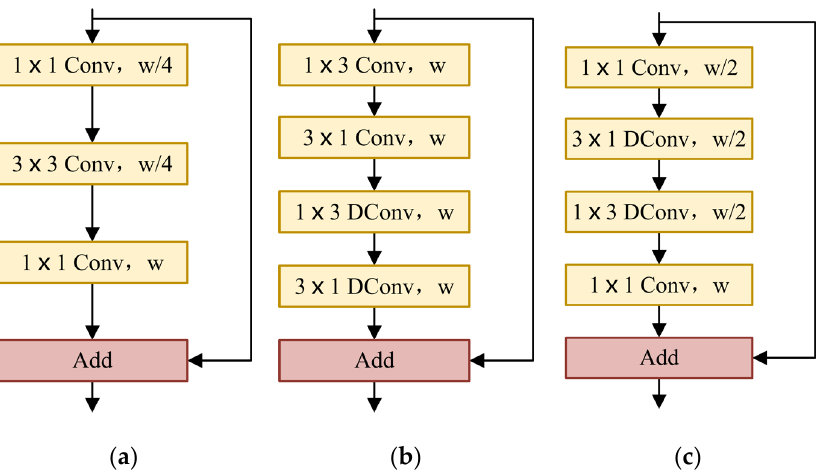
Figure 2. ( a ) ResNet bottleneck design. ( b ) ERFNet non-bottleneck-1D module. ( c ) Our LAB module. w: the number of input channels; DConv: depthwise dilated convolution.